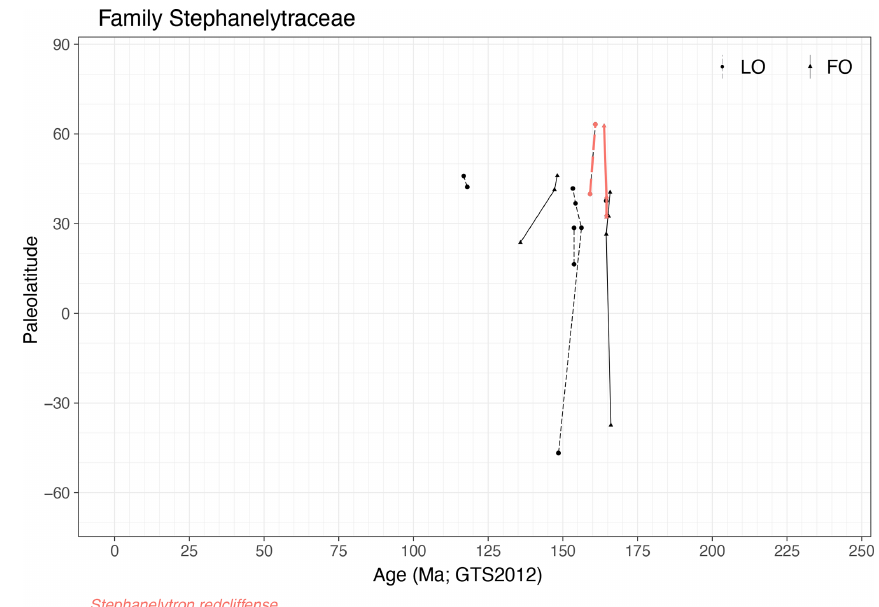
Figure 19. Same as Fig. 5 but for the family Stephanelytraceae.